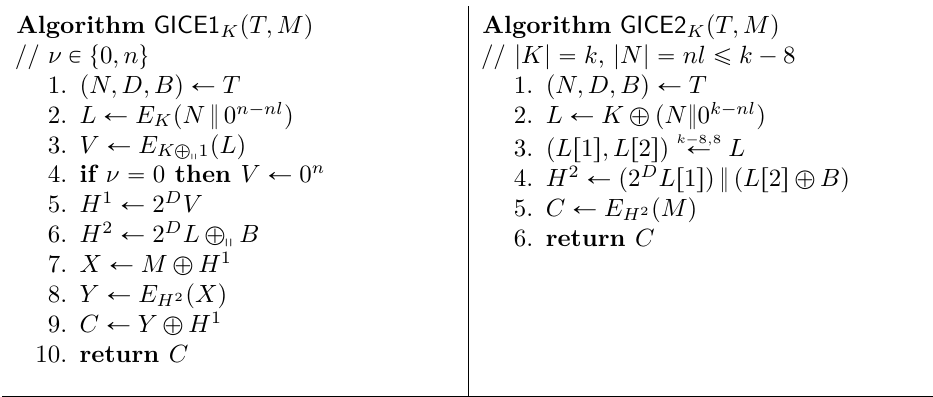
Figure 13: Abstraction of ICE1 and ICE2 ( GICE1 ) and ICE3 ( GICE2